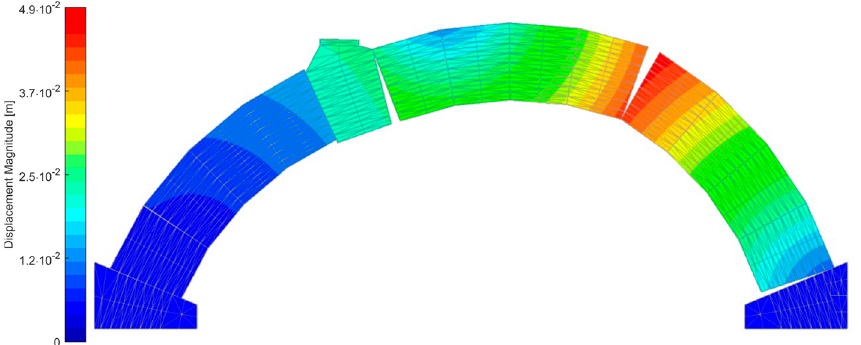
Figure 16. Failure mode of Pulatsu’s geometry for best set of material parameters using objective function 1; the colour legend represents the displacements in metres.